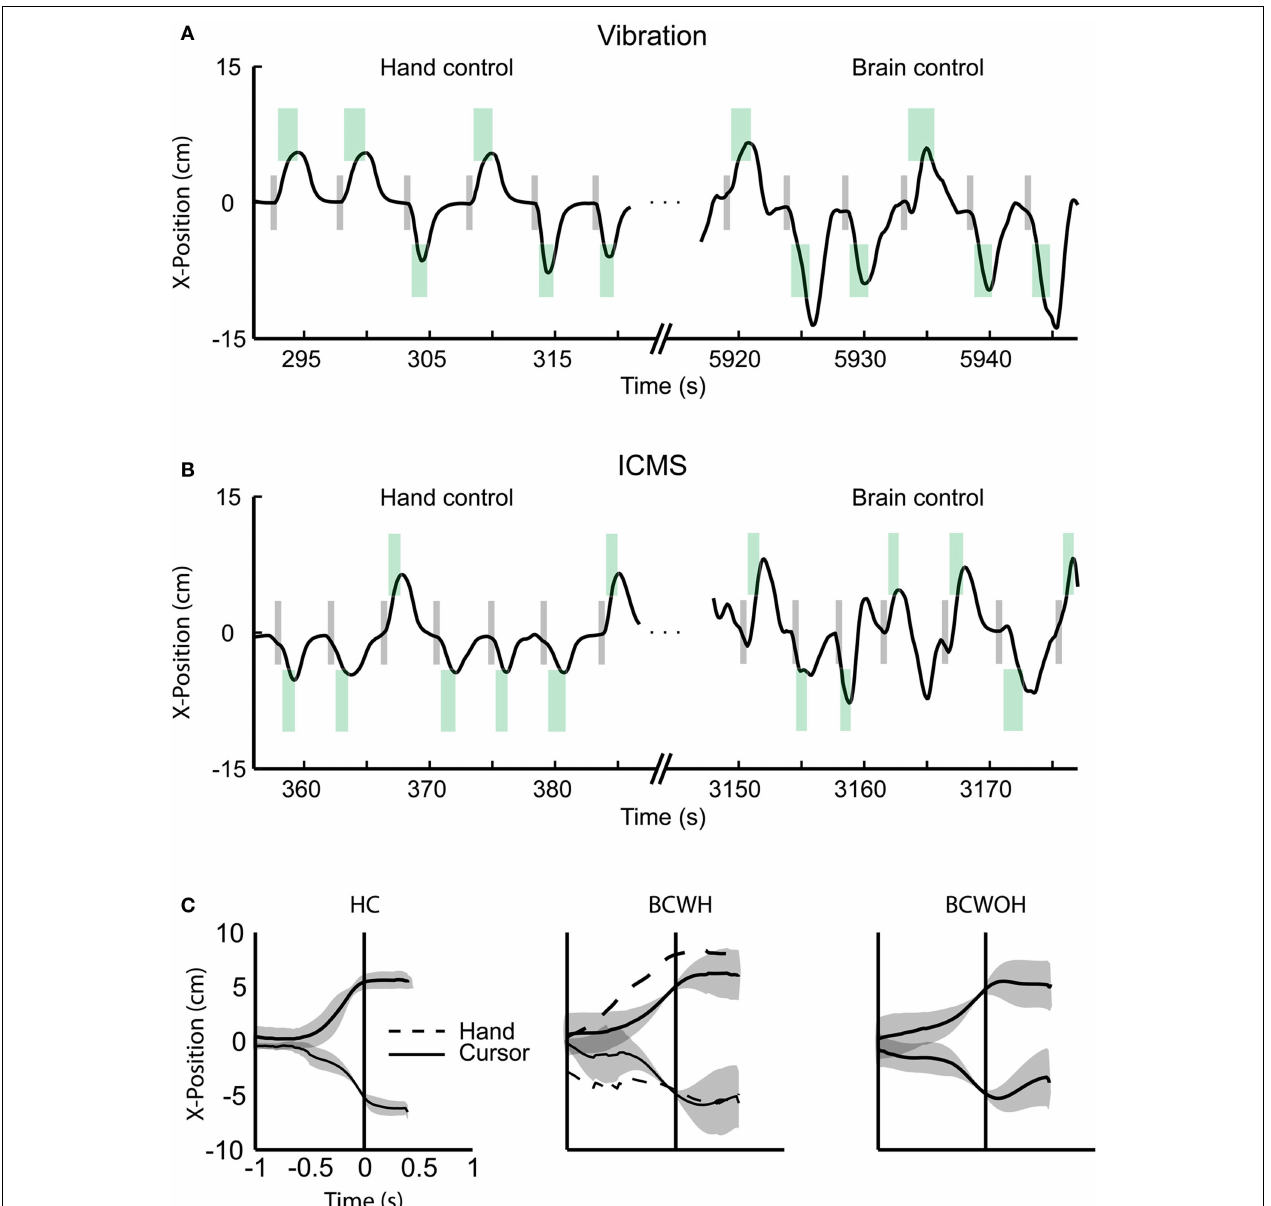
movements made by Monkey 1 in the left and right directions for hand control, HC (left), BMI control with hand movements, BCWH (middle) and BMI control without hand movements, BCWOH (right). Trajectories are aligned on the time of target acquisition. Solid trace indicates mean cursor movements and dashed trace indicates mean hand movements. Shaded region is standard deviation of cursor